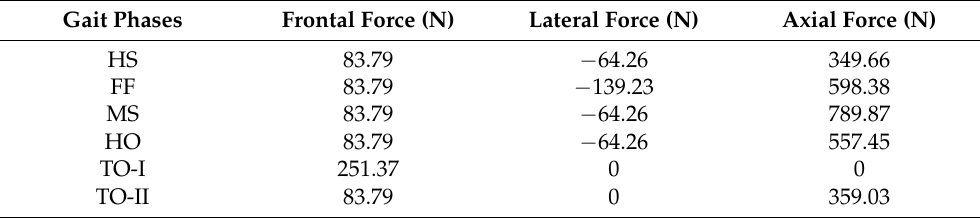
Figure 1. Six phases of the human walking gait cycle. Table 2. Average frontal, lateral, and axial forces acting on the femur within six gait